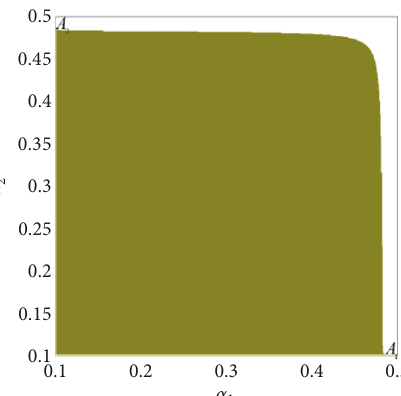
Figure 1: The stability region of the Nash equilibrium point 𝐸 3 on the parameter plane (𝛼 1 , 𝛼 2 )